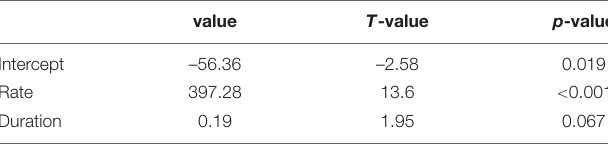
TABLE 6 | Parameter estimates of wood cell development linear model against rate and